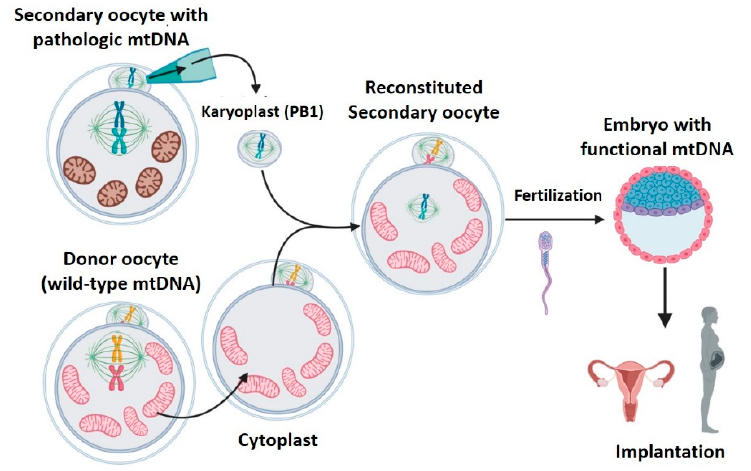
Figure 7. First polar body transfer (PB1T). PB1T consists of transferring the first polar body from a patient’s oocyte in metaphase II to a donor oocyte (also in metaphase II) whose meiosis spindle has been previously removed. Created with BioRender.com